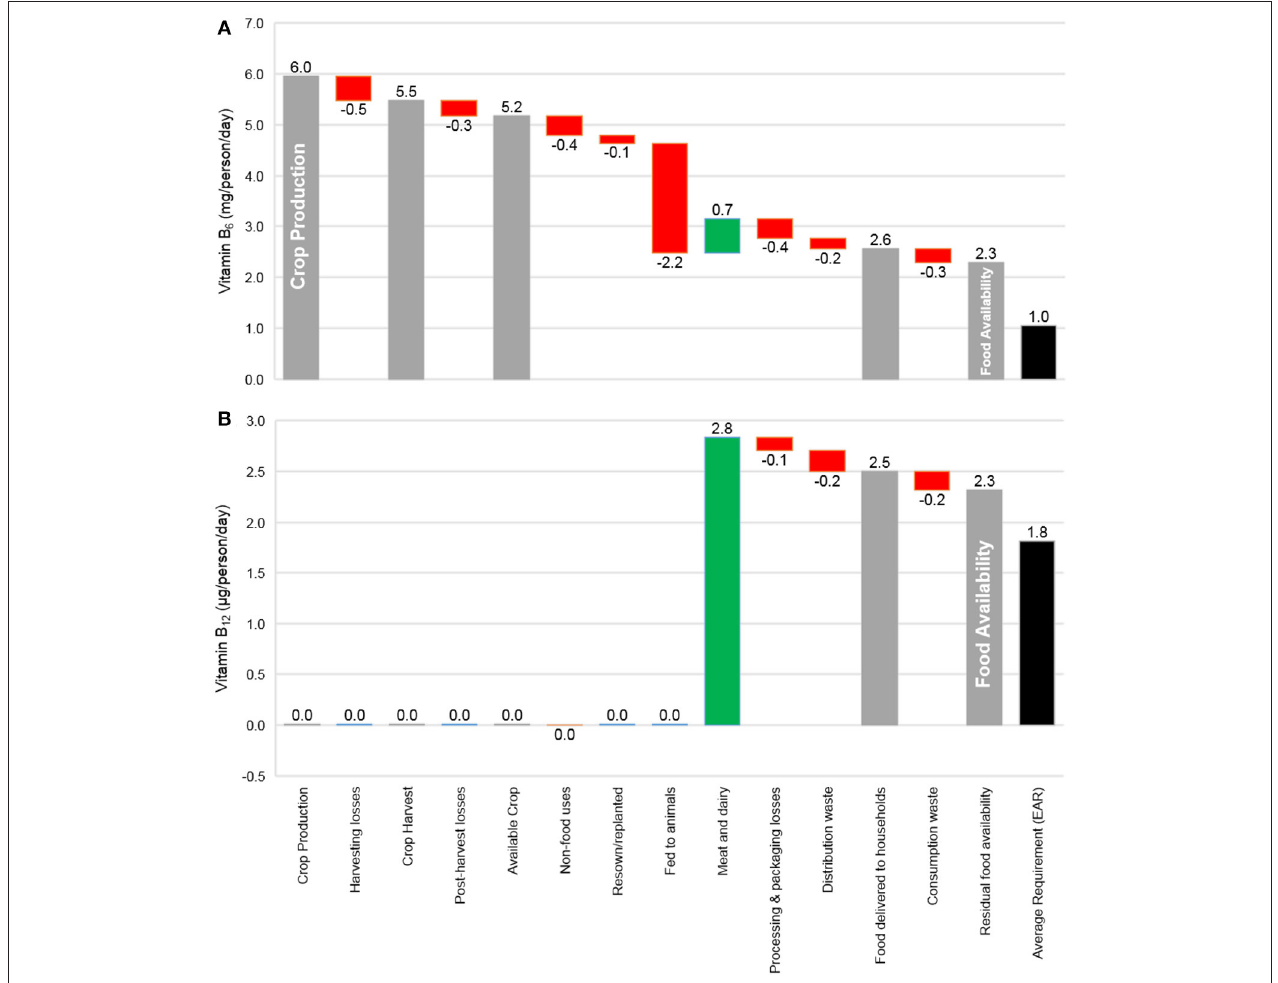
FIGURE 4 | Production and losses of micronutrients in the global food system from “field to fork” in 2011. Food pathways in (A) vitamin B 6 ; and (B) vitamin B 12 from crop production to residual food availability, normalized to average per capita levels assuming equal distribution. Red bars (negative numbers) indicate food system losses; green bars indicate meat and dairy production; and gray bars indicate macronutrient availability at intermediate stages of the chain, with the estimated average requirement shown in